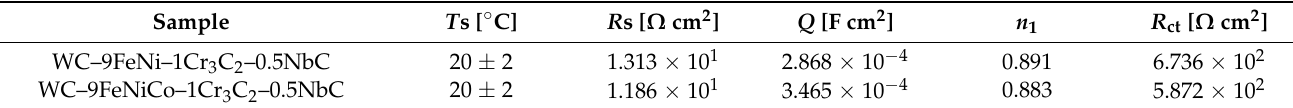
Table 5. The results of the EIS